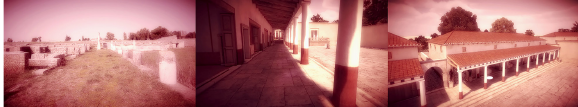
Figure 6. Virtual Museum of the Tiber Valley, Lucus Feroniae scenario. Observed and reconstructed landscapes are compared Each scenario needs from 5 to 10 minutes to be enjoyed. The user is involved in that flow and rhythm, his experience is multi-sensorial and